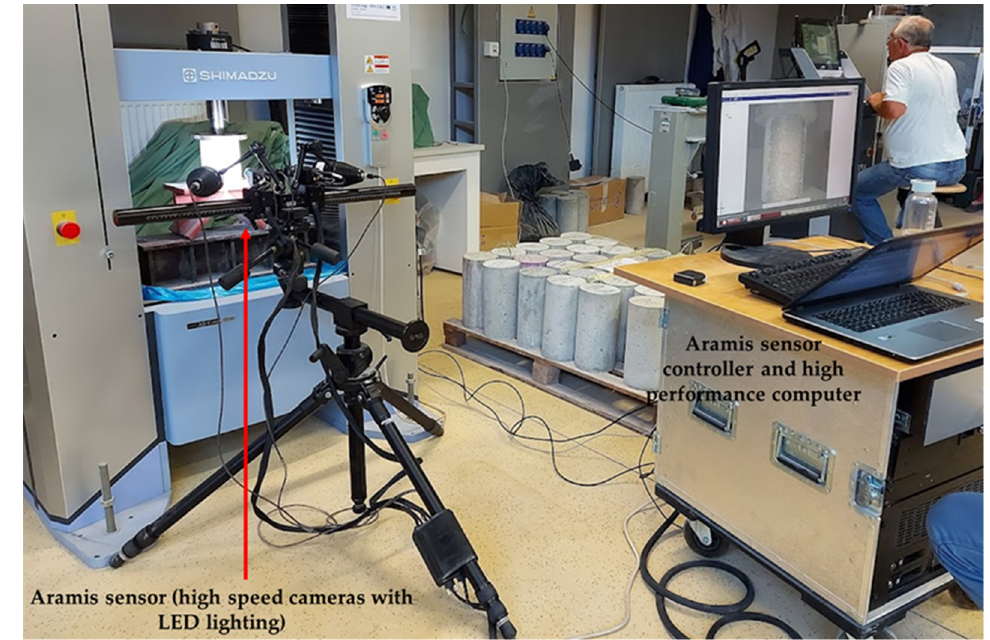
Figure 3. The 3D-DIC testing setup.